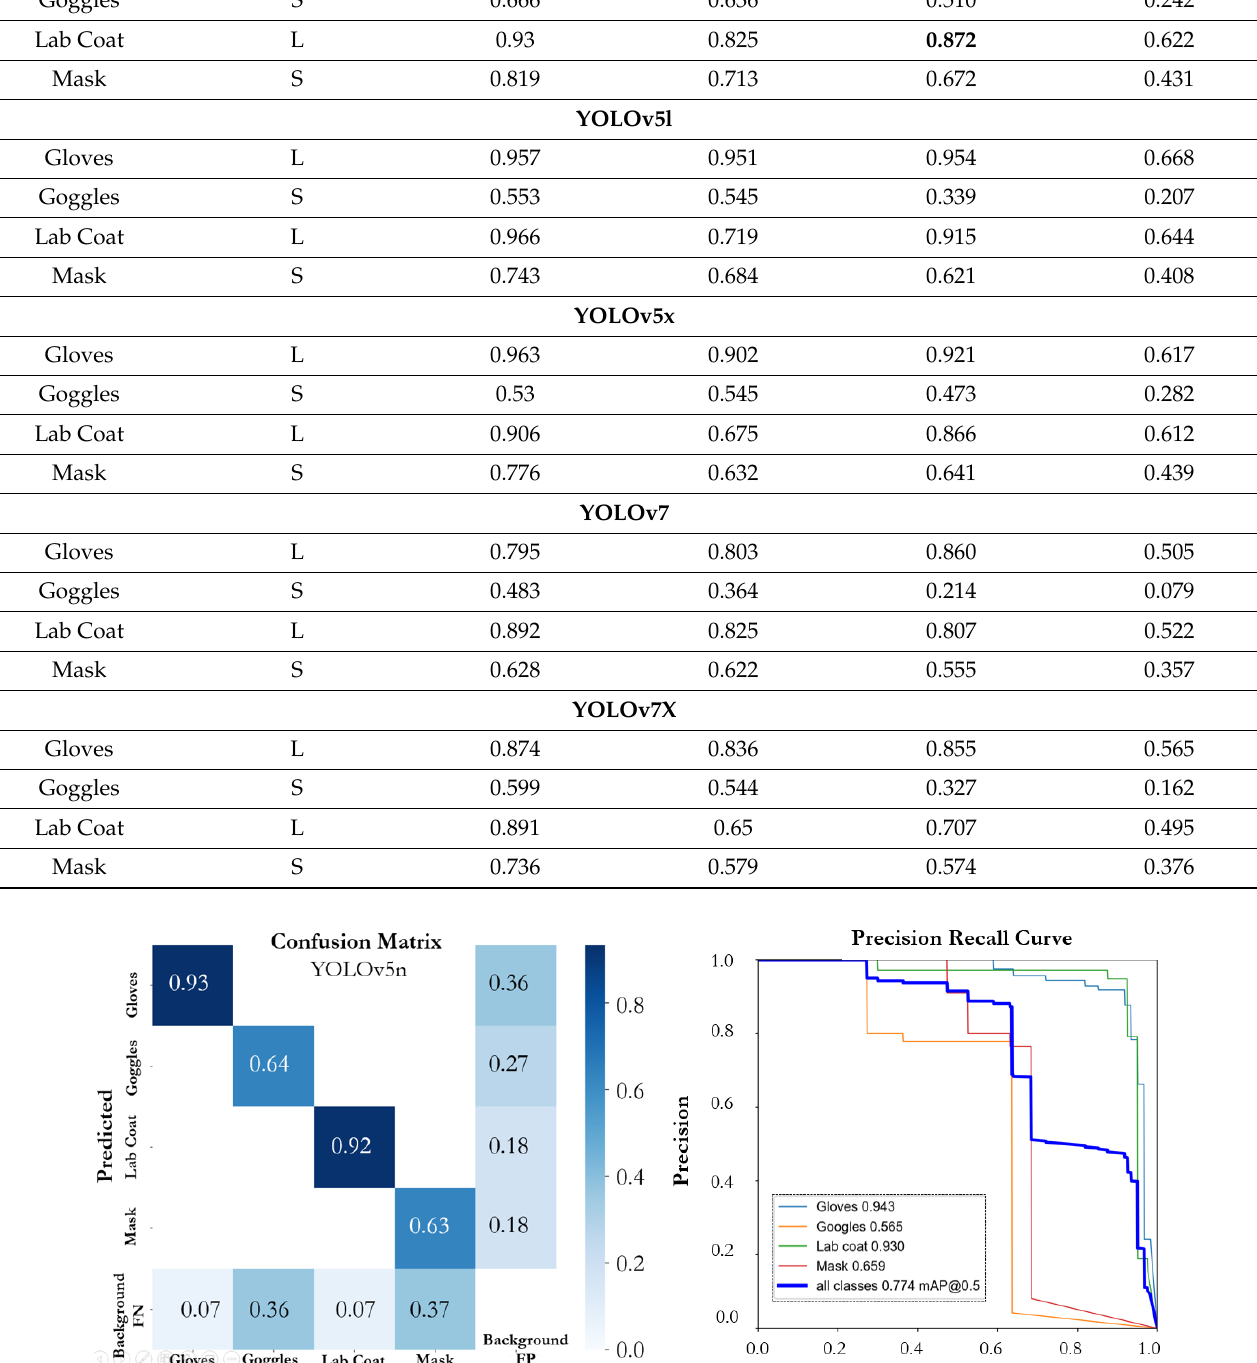
Figure 9. Confusion matrix and PR curve of the YOLOv5s model. Figure 10. Confusion matrix and PR curve of the YOLOv5m model.